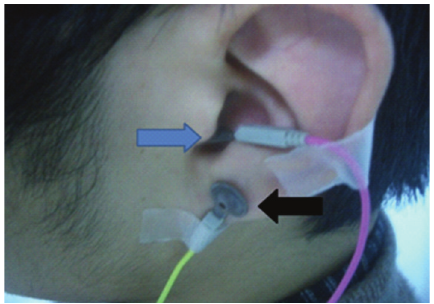
Figure 1: The recording electrode of the posterior wall of the external auditory canal (blue arrow) and the reference electrode of posterior wall of the earlobe (black